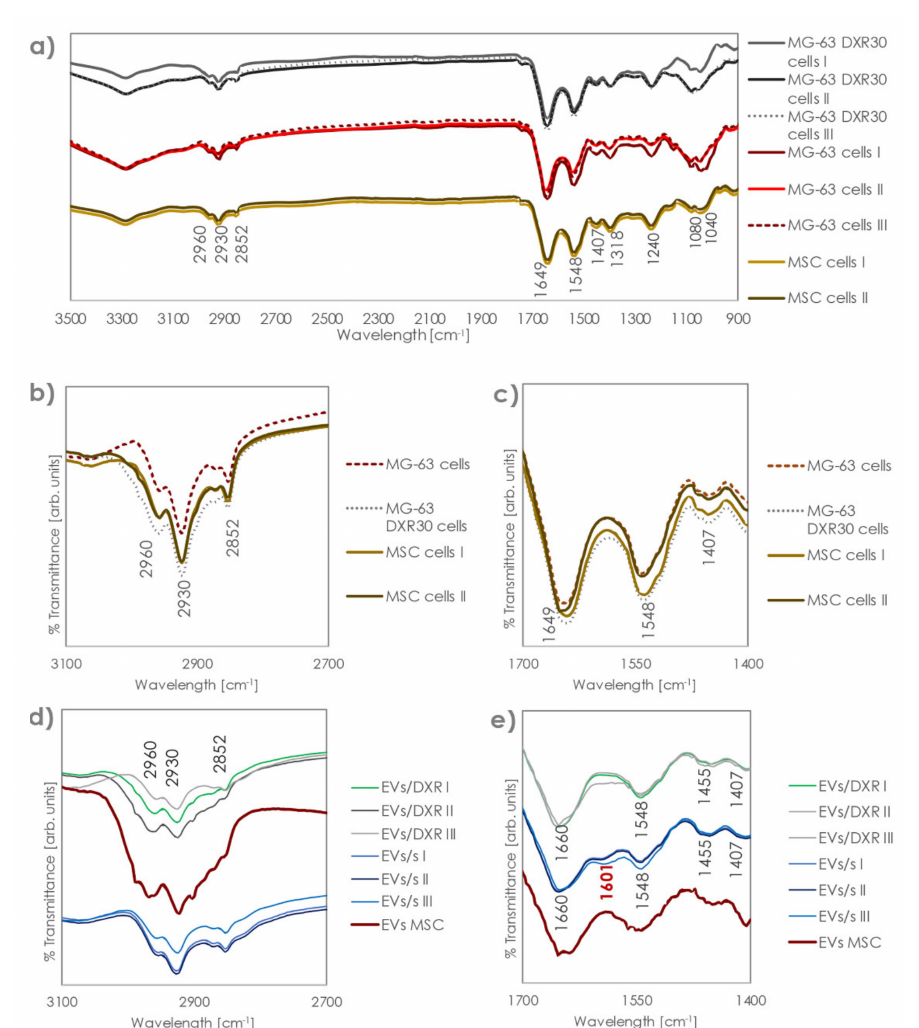
Figure 5. FT–IR/ATR spectra of OS EVs/s, OS EVs/DXR, MSC EVs, and cells from which they were derived. ( a ) FT–IR spectra after subtracting the PBS reference curve and zooms on the ( b ) lipid and ( c ) protein areas for OS and ADMSC cells. Panel ( d , e ) highlight the band region corresponding to protein and lipid zones, respectively, for EVs